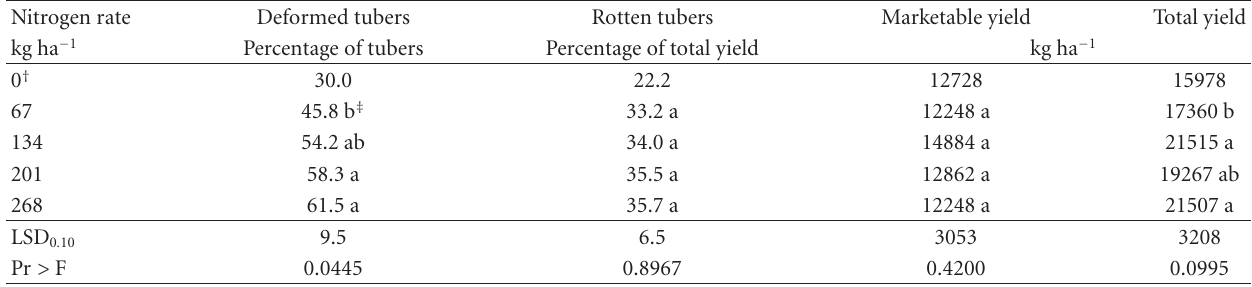
Table 2: Nitrogen rate main e ff ect in 2009 for deformed tubers, rotten tubers as a percentage of total yield, marketable tuber yield, and total tuber yield for Russet potatoes grown on sandy loam soils in the Mid-Atlantic, averaged across Russet cultivars and N application timing.